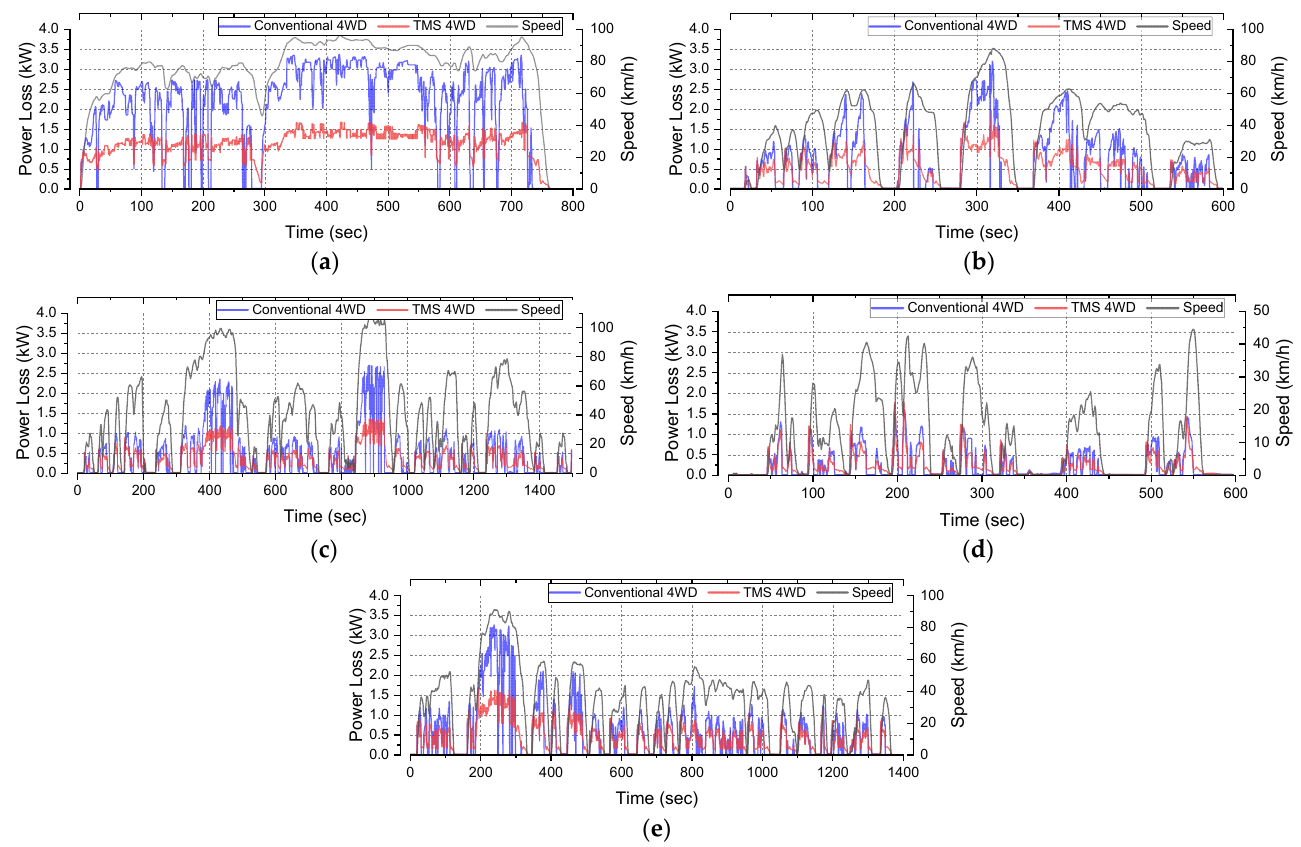
driving condition of less than 100 kph (60 mph). SC03 has a cycle of 600 s as an air